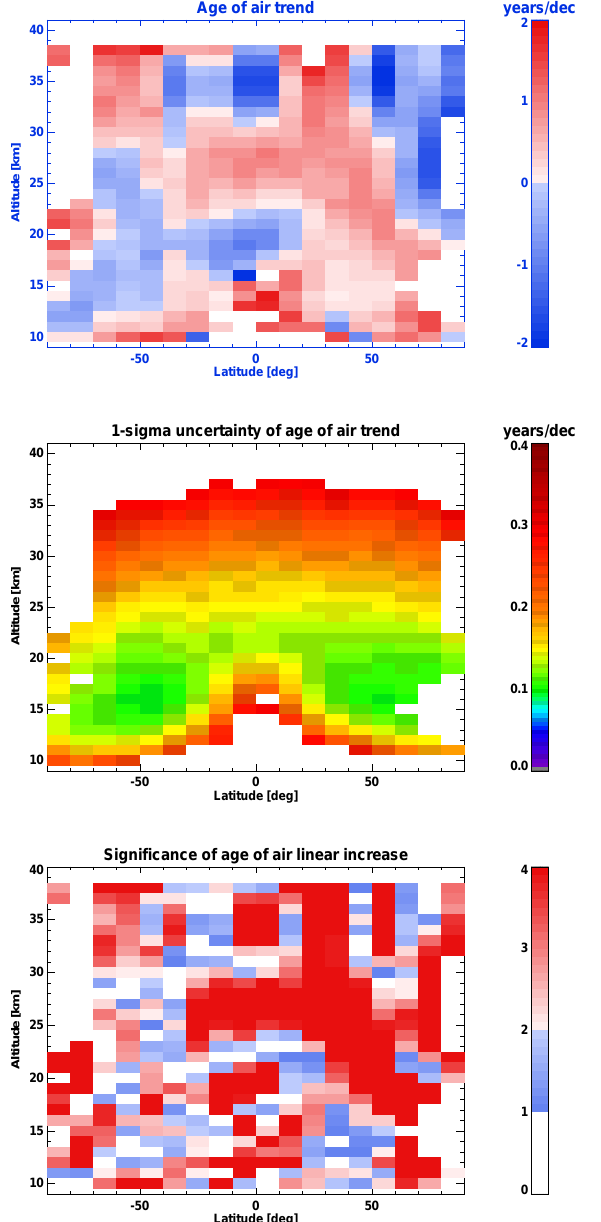
Fig. 10. Altitude-latitude cross-sections of the age of air linear increase/decrease over the years 2002 to 2010 (top), together with its 1- σ uncertainties (middle) and significance in terms of multiples of σ (bottom). 41